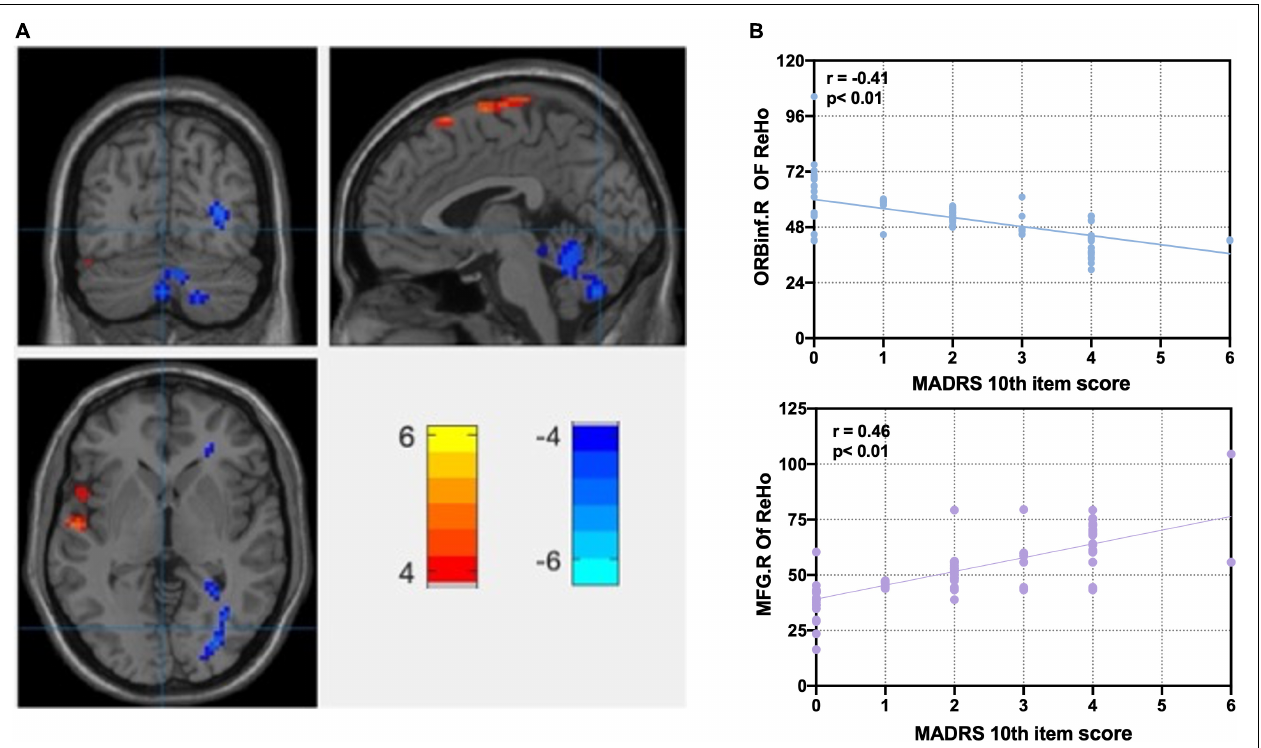
FIGURE 1 | Correlation analysis of significant ReHo differences between MDD and HC groups with MADRS 10th item score. (A) Statistical map depicts higher and lower ReHo of MDD compared with HC groups. Abnormal ReHo of anterior cingulate cortex, prefrontal lobe, parietal cortex, and cerebellum. Disrupted regional homogeneity of the core brain region of CON at rest. (B) Correlation analyses between ReHo and MADRS 10th item score. Blue denotes lower ReHo, and red denotes higher ReHo. L, left side; R, right side; ReHo, regional homogeneity; ORBinf, right orbital inferior frontal gyrus; MFG, middle frontal gyrus; MADRS, Montgomery–Asberg Depression Rating Scale; FDR, false discovery rate; MDD, major depressive disorder. FDR p < 0.05. MADRS 10th item score: suicidal ideation, 0–6